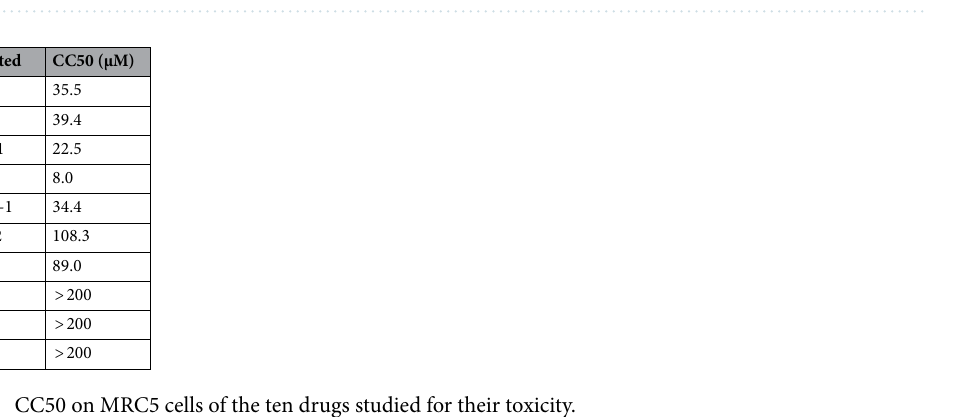
Figure 1. Viability of MRC5 cells under treatment with the ten drugs using MTT toxicity assay. ( A ) High cytotoxicity was observed for MBA112, MBA33, MBA27-1, OS4-1 and MBA108-1, ( B ) intermediate cytotoxicity for MBA152 and 5c and ( C ) low cytotoxicity for MBA140, LIJ2P40, and MBA28. MTT assays were performed after 48 h. Untreated cells were used for normalization of MTT assay. Results are represented as mean ± SD of three independent experiments.